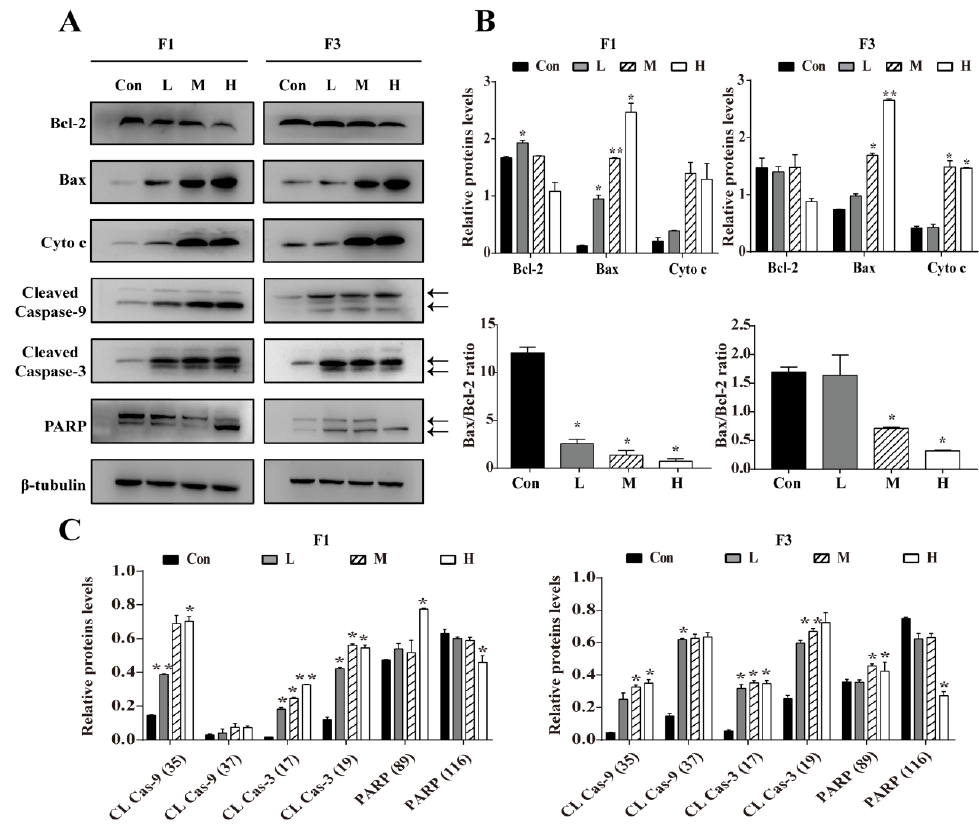
Figure 4. Apoptosis-associated proteins in Jurkat cells treated by F1 or F3 were analyzed by West- ern blot. ( A ) The expression of Bcl-2, Bax, Cytochrome c (Cyto c), Cleaved Caspase-9 (35/37 KD), Cleaved Caspase-3 (17/19 KD), and PARP (89/116 KD) in Jurkat cells treated by various concentrations of F1 or F3. β-tubulin was used as an internal control. ( B ) The histogram showed the relative protein levels and Bax/Bcl-2 ratio in Jurkat cells treated by F1 or F3. ( C ) The histogram showed the relative protein level in Jurkat cells treated by F1 or F3. Data were presented as mean ± SEM of three independent experiments; * p < 0.05 and ** p < 0.01 vs. the control group. The uncropped Western Blot images can be found in Figure S3.